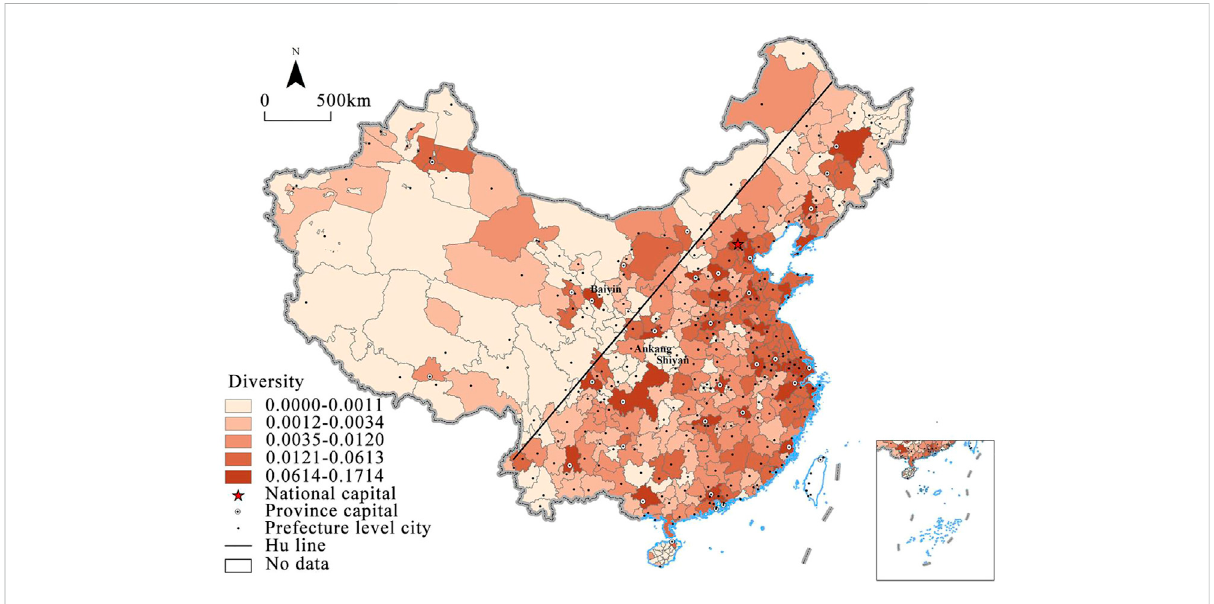
Spatial distribution of the diversity of China ’ s urban innovation